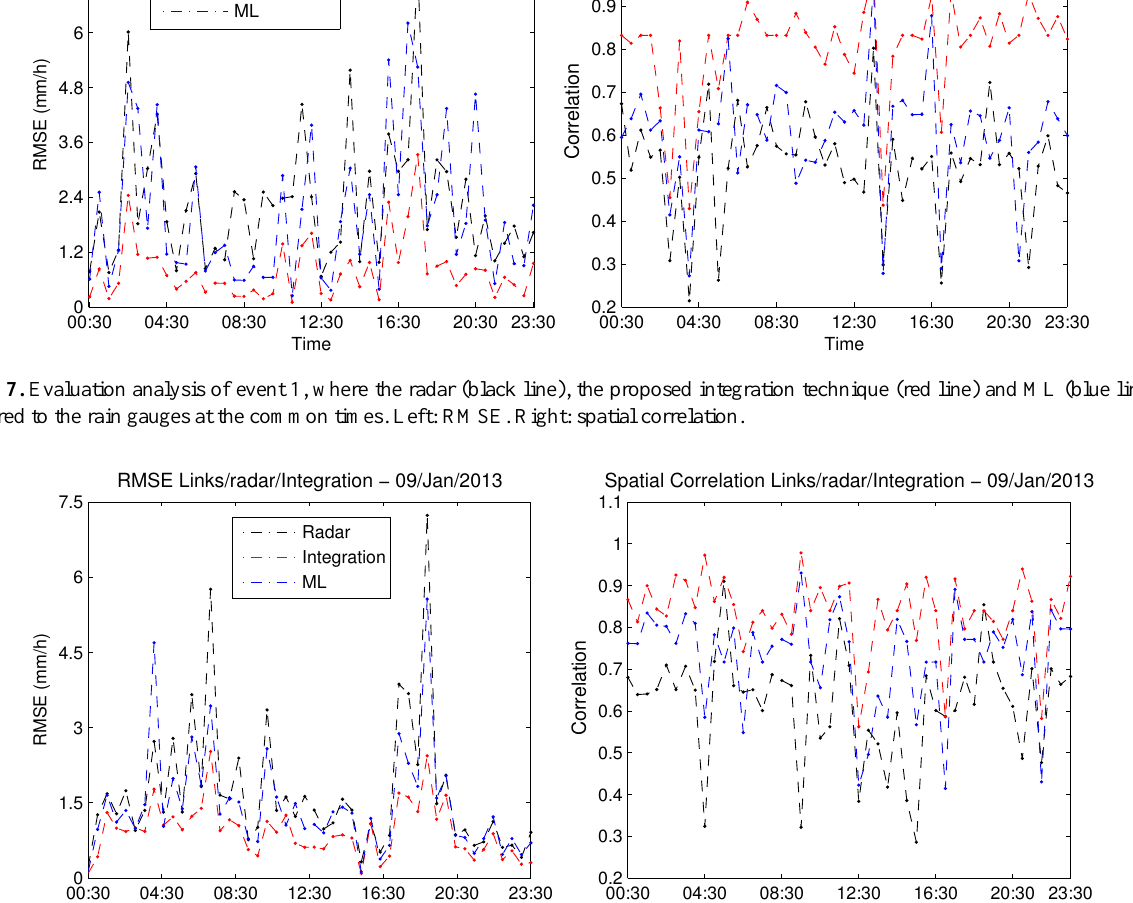
alarms, the given criteria can be evaluated by POD , S FAR , F ; CSI F + S